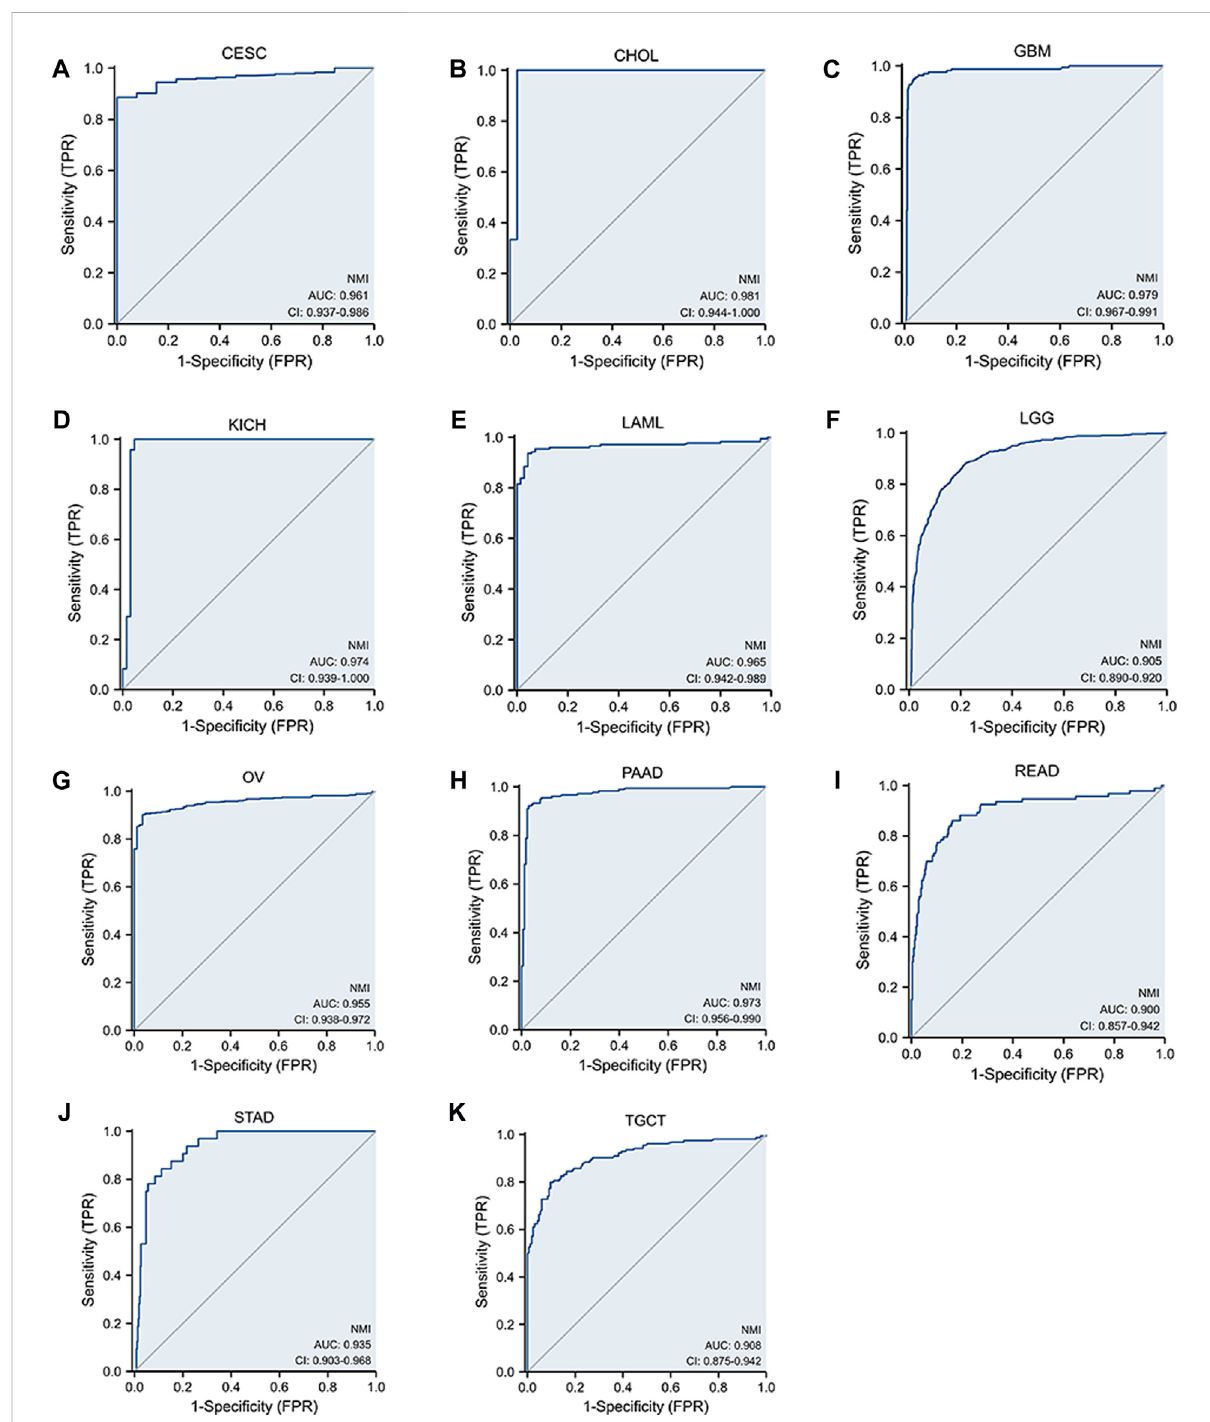
FIGURE 5 ThesensitivityofNMItotumordiagnosisisrepresentedbytheROCcurve. (A) CESC, (B) CHOL, (C) GBM, (D) KICH, (E) LAML, (F) LGG, (G) OV, (H) PAAD, (I) READ, (J) STAD, and (K)